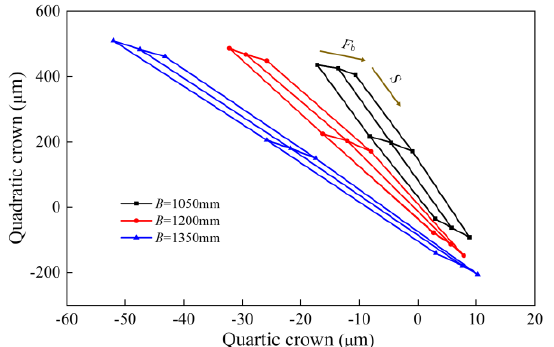
Figure 8. Influence of strip width on crown adjustment